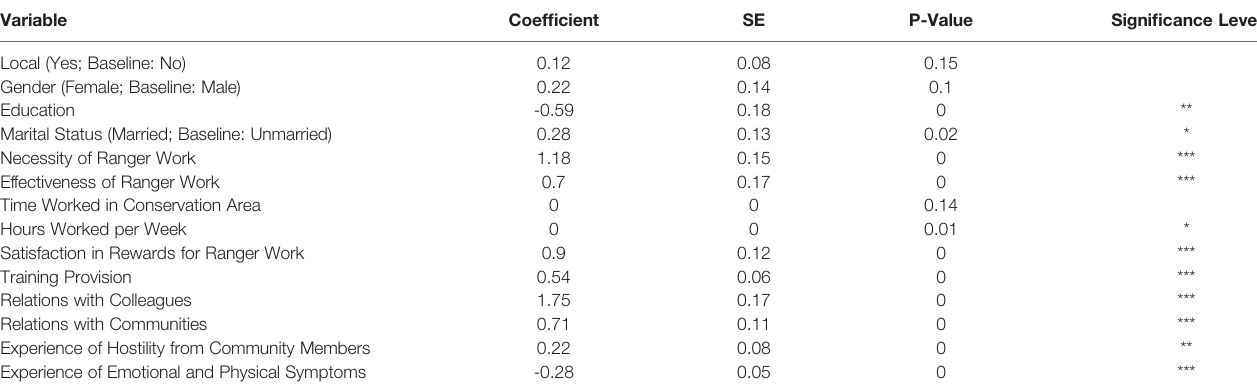
TABLE 6 | Coef fi cients, standard errors (SE) and p-values for the fi nal ordinal model with job satisfaction as the dependent variable and various demographic and occupational factors as the independent variables. Variable Coef fi cient SE P-Value Signi fi cance Level Local (Yes; Baseline: